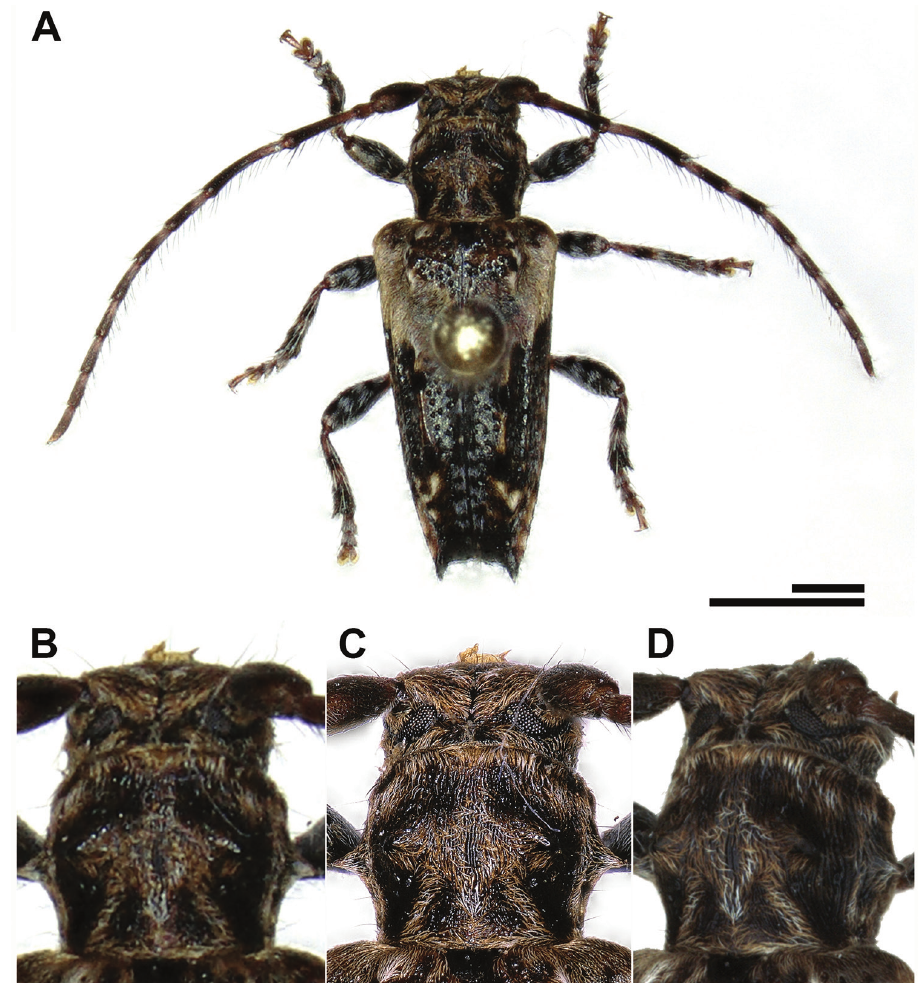
Figure 8. Comparison of images taken with a Keyence VHX 5000 digital microscope (lens: Z20, A–C ) and DISC3D ( D ). The whole specimen of Pogonocherus hispidus can be imaged at once with the VHX 5000 with a X30-magnification ( A ). To compare the digital resolution, we focus on the pronotum of the beetle ( B : VHX 5000, ×30; C : VHX 5000, ×100, D : DISC3D, ×1.26). Scale bars: 1